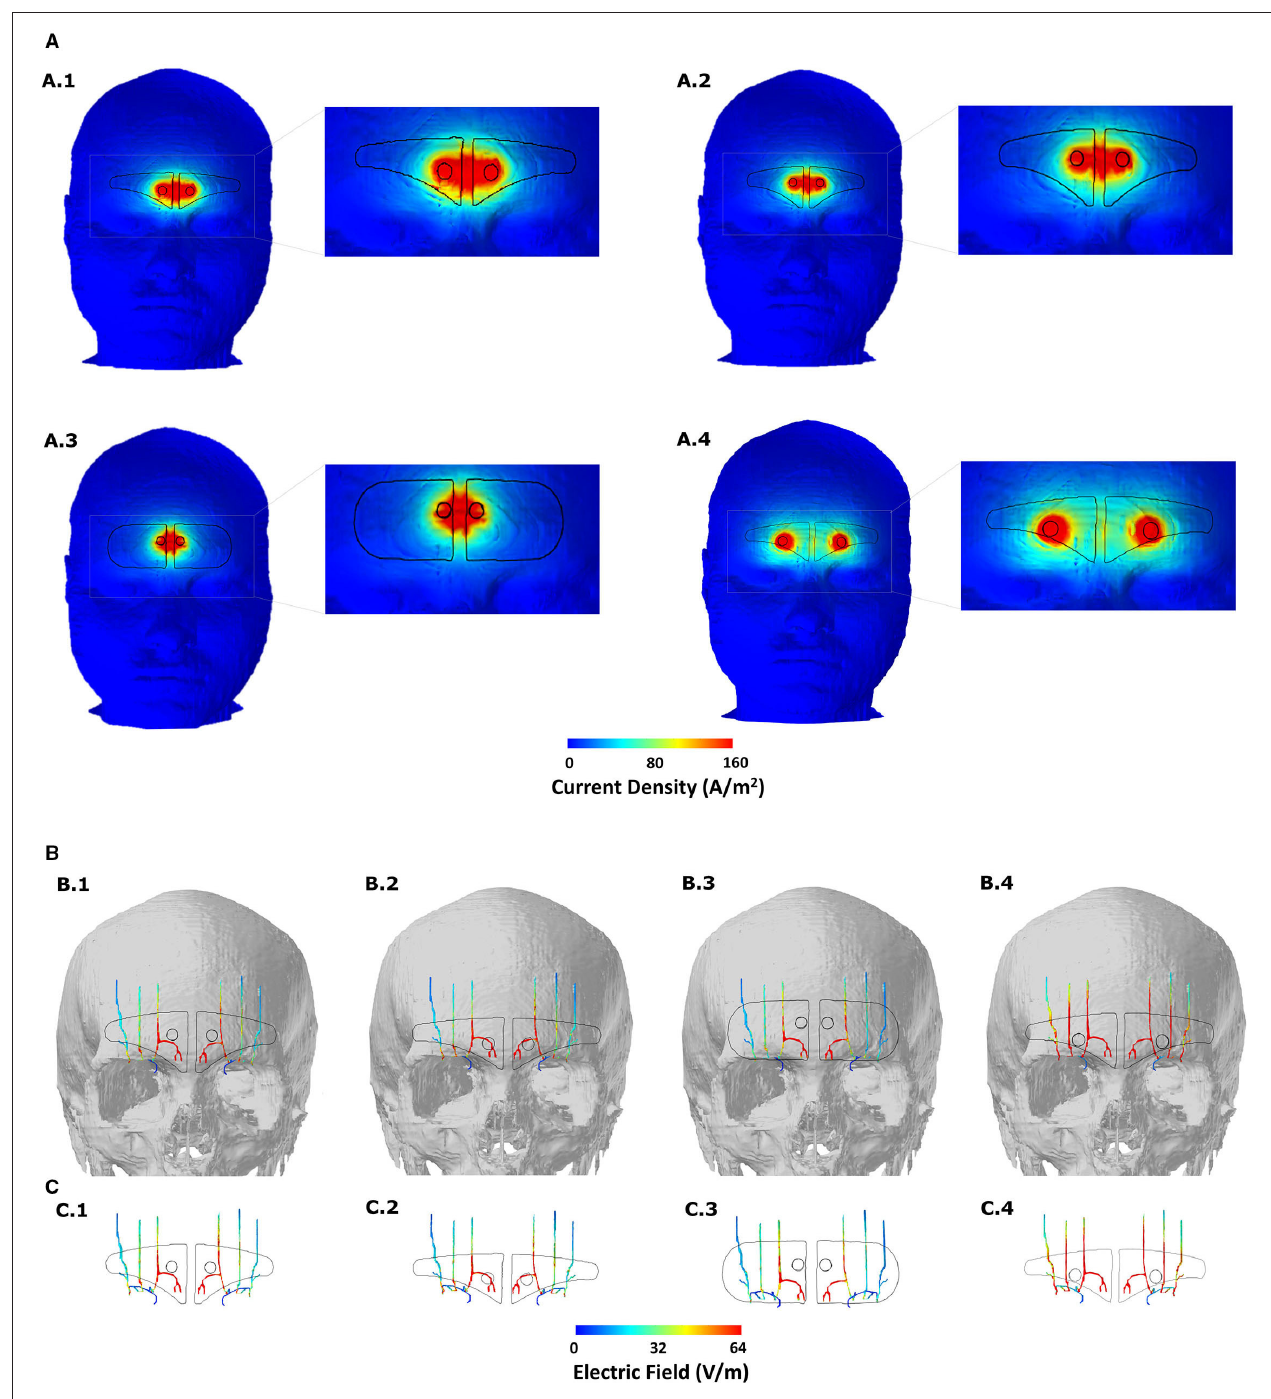
FIGURE 3 | Induced current flow pattern for each of the four-electrode configurations (A) Scalp current density plots. The dashed section in each image is expanded in the immediate right to better elucidate current flow patterns. Current shunting dominates across the two contacts for the first three montages and contact separation distance plays a defining role in the overall current flow pattern. Increasing the contact separation results in individual current concentration at the location of the two contacts reflecting less shunting and more inward flow into the underlying tissues. (B) Induced EF on the surface of the target nerves. The skull mask is included in the background to help related flow to the anatomical location. (C) Same and (B) but without any background. All EF images are plotted to the mean induced value on the ST nerve due to the V-shaped or clinically approved design (see Table 4 ).